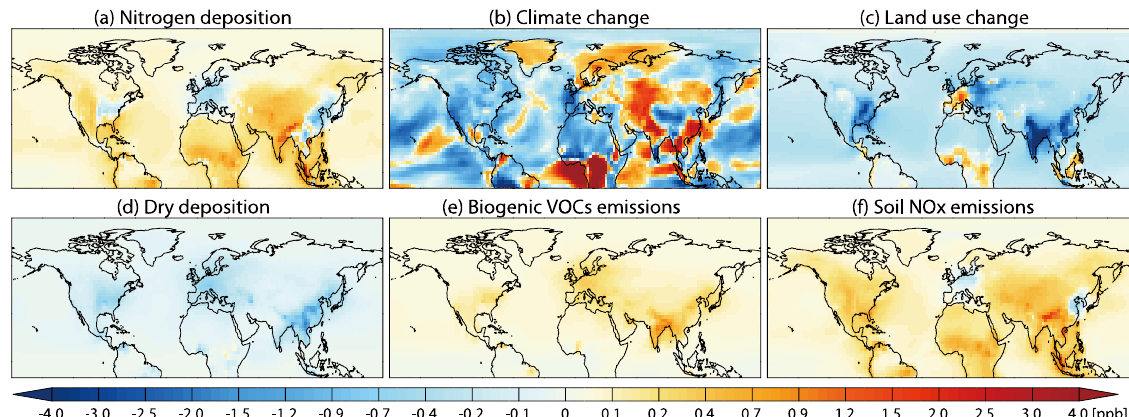
Figure 7. Same as Fig. 6 but for